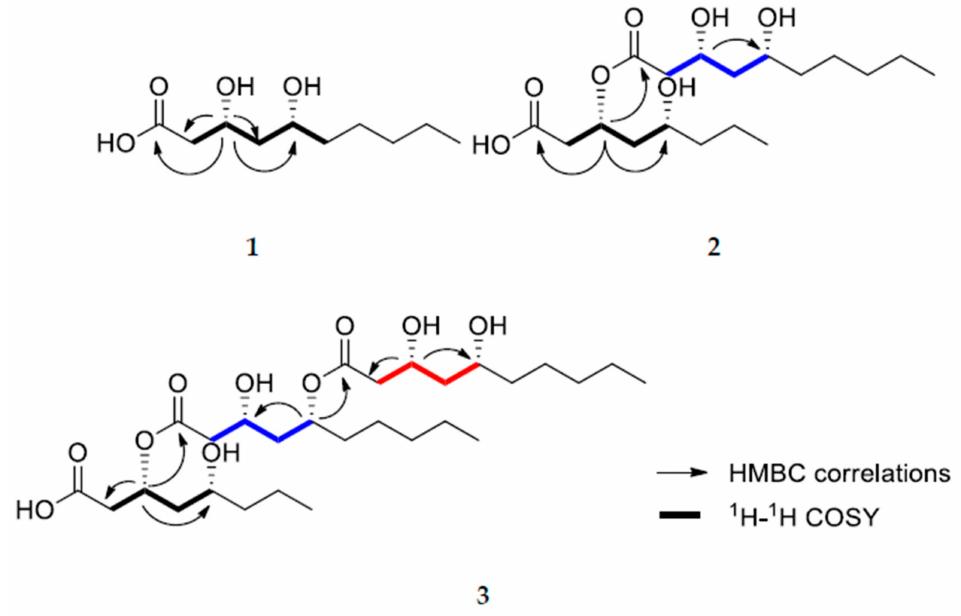
Figure 2. Key HMBC correlations for compounds 1 – 3 and 1 H- 1 H COSY